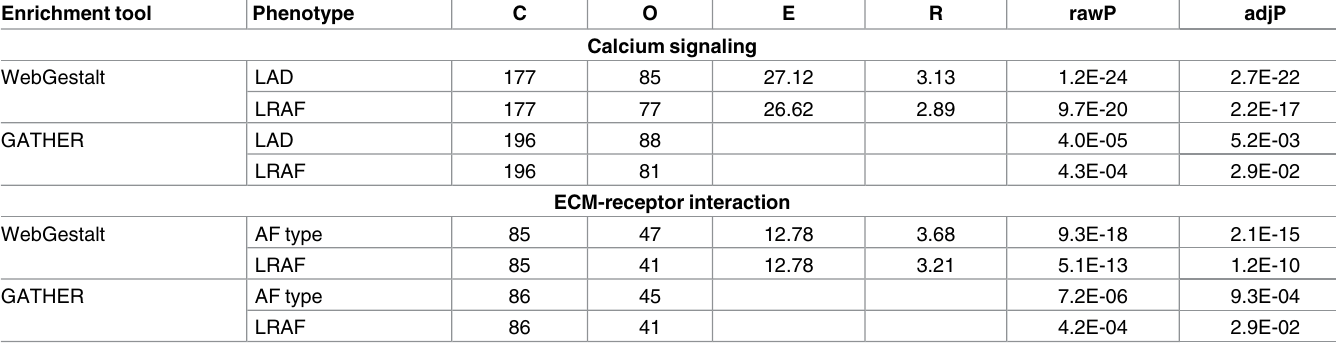
Table 2. Calcium signaling and ECM-receptor interaction pathways and their association with LAD, AF type and arrhythmia recurrenceusing two enrichment tools. Enrichment